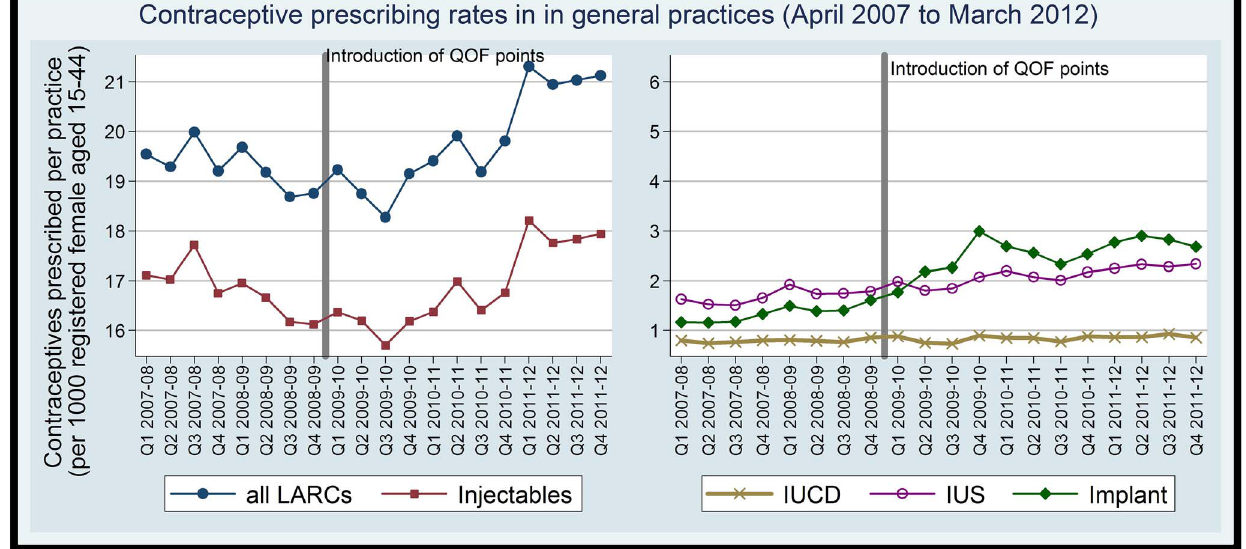
Figure1. LARC prescribing rate in general practices for registered women aged 15–44 years.